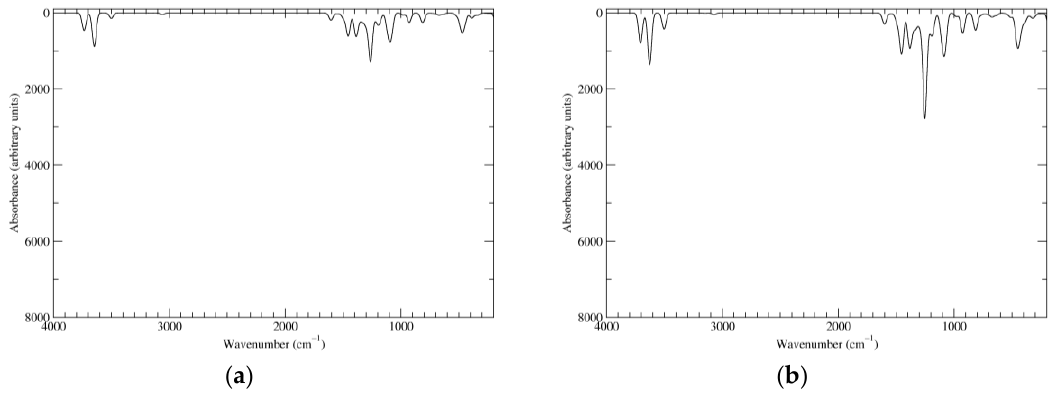
Figure 2. Computed infrared (IR) spectra of the most significant tautomers/conformers in the reduced state. ( a ) Neutral form in vacuo, a0_b0_c0_d0, S 4 . ( b ) Neutral form in water, a0_b0_c0_d0, S 4 .